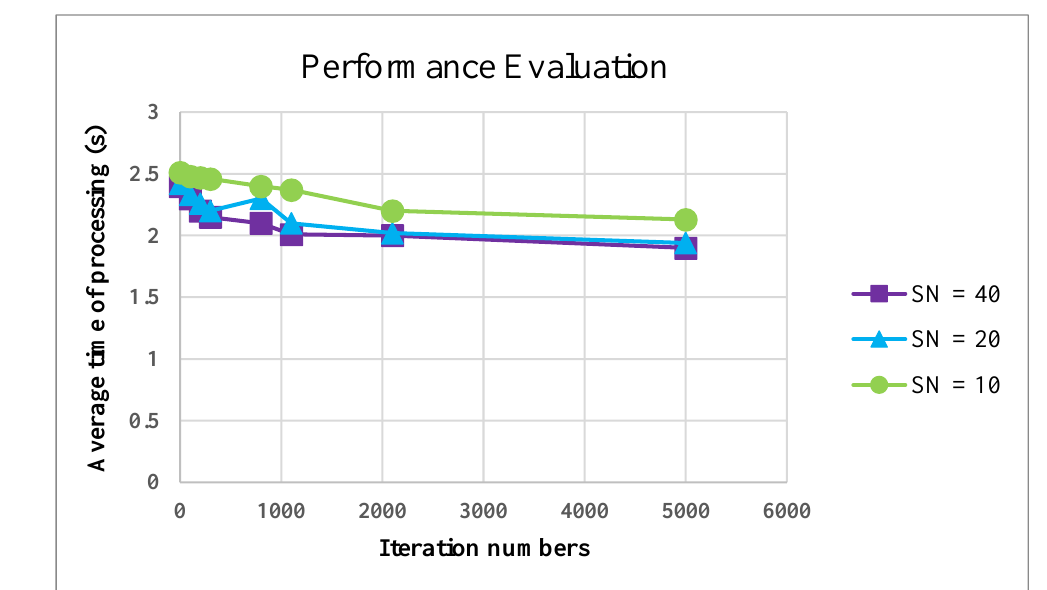
Figure 9. Performance evaluation of various solution number (SN) settings.